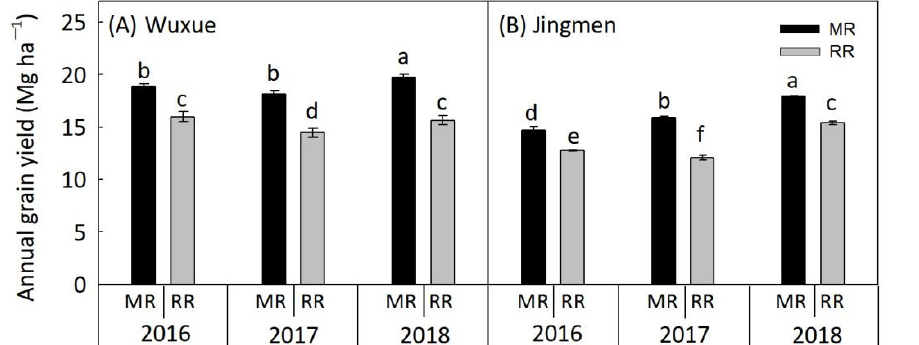
Figure 2. Annual grain yield for MR and RR cropping system at Wuxue ( A ) and Jingmen ( B ) from 2016 to 2018. Different letters indicate significant differences between values within the same column among 3 years according to the least significant difference (LSD) test ( p < 0.05). MR: maize–rice cropping system; RR: double-rice cropping system.